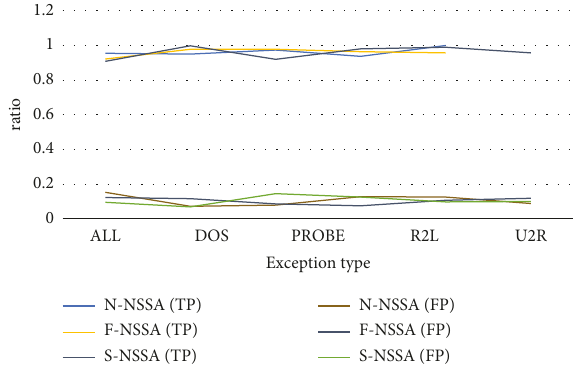
Figure 8: Comparison of detection rate and false detection rate of three models.